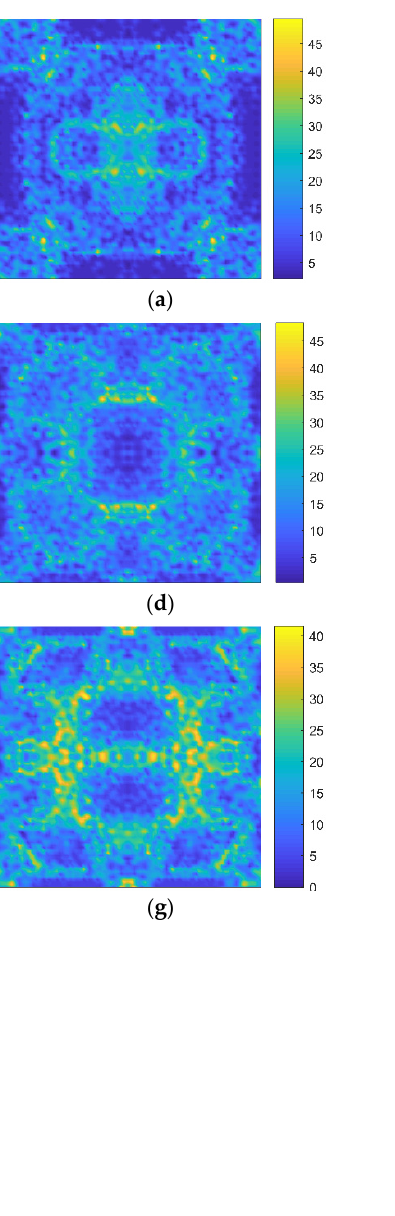
( d ) Figure 7. The comparison for number distributions of indistinguishable atoms (( a , b ) represent the 1st and 10th resonant vibration modes with limitation at 10 − 5 , while ( c , d ) represent those at 10 − 7 , respectively).